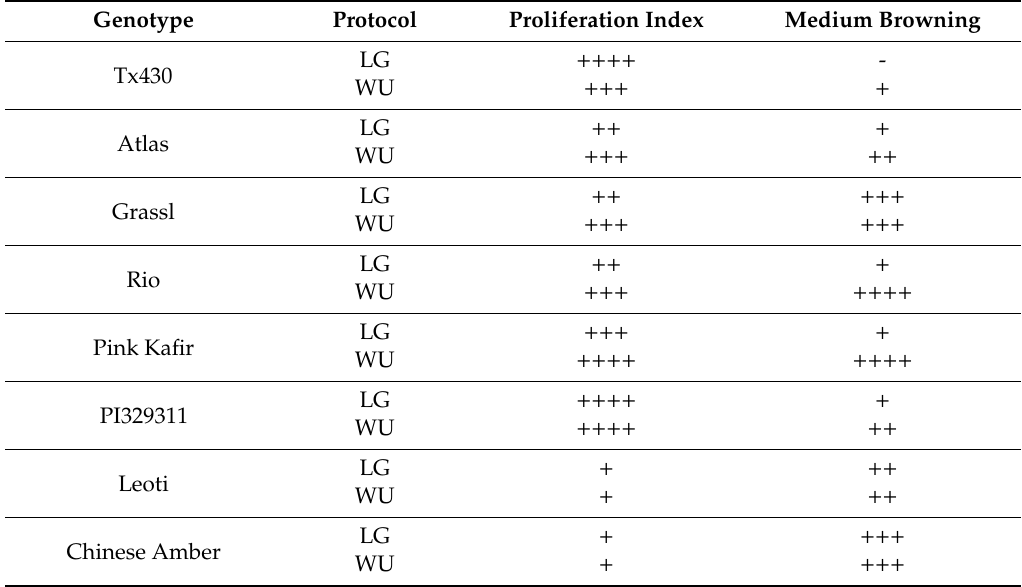
Figure 3. Impact of LG and WU RM on explant phenotype for the various genotypes, following four weeks of culture on RM. Representative photos of petri plates for each genotype and protocol combination illustrating the levels of callus proliferation and medium browning. Table 1. Impact of genotype and protocol on callus proliferation and medium browning on